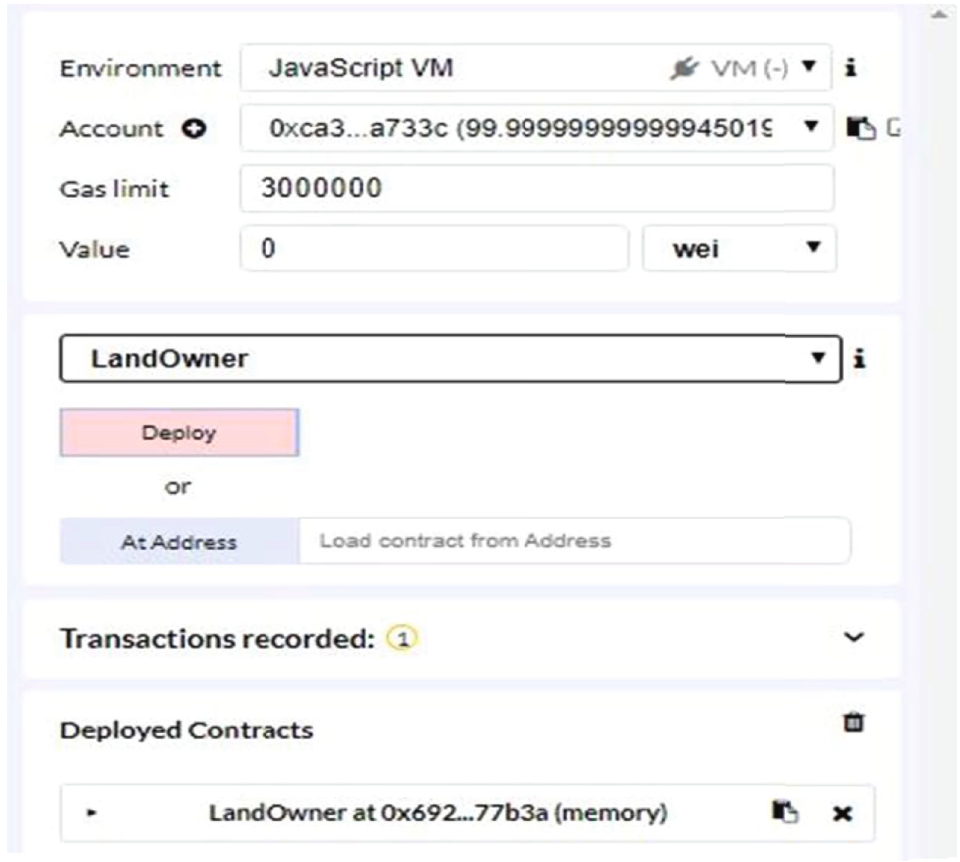
Figure 15: Transaction